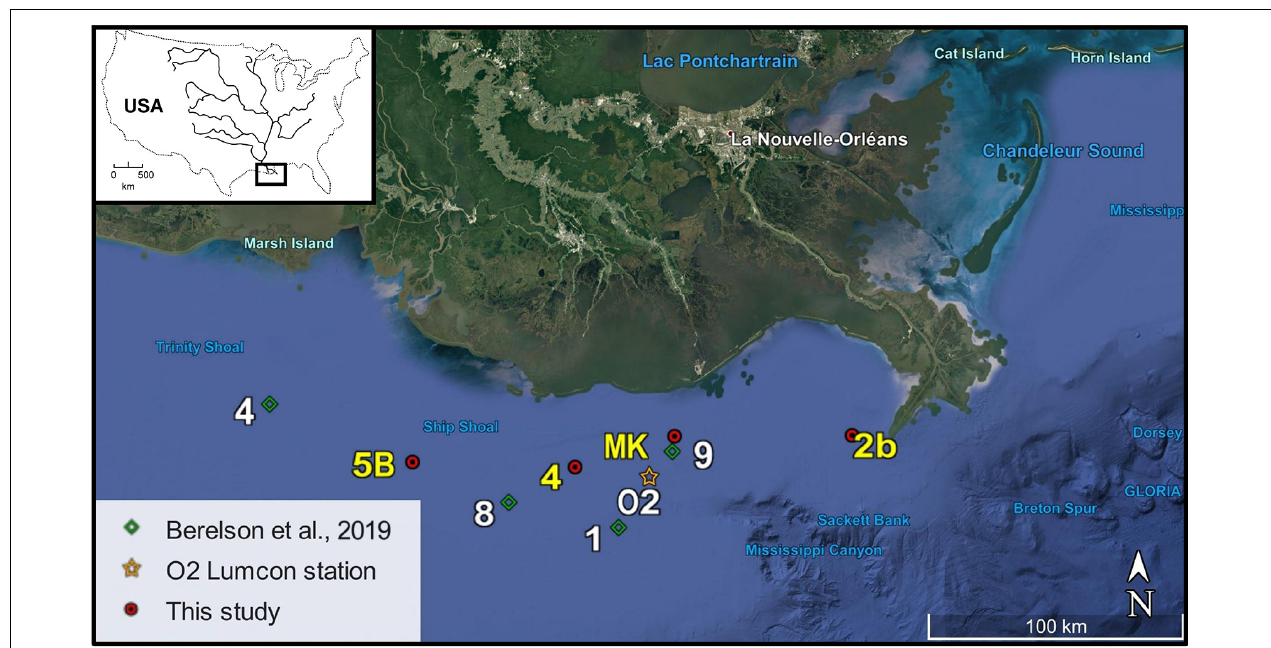
FIGURE 1 | Map of the Louisiana shelf showing the location of the four stations (2b, MK, 4, and 5B) sampled by the R/V Savannah in July-August 2017. Station O2 (orange star) refers to the seasonal monitoring station C6C maintained by LUMCON with bottom water oxygen measurements, whereas stations 1, 8, and 9 (green diamonds) refer to Berelson et al. (2019) benthic chamber